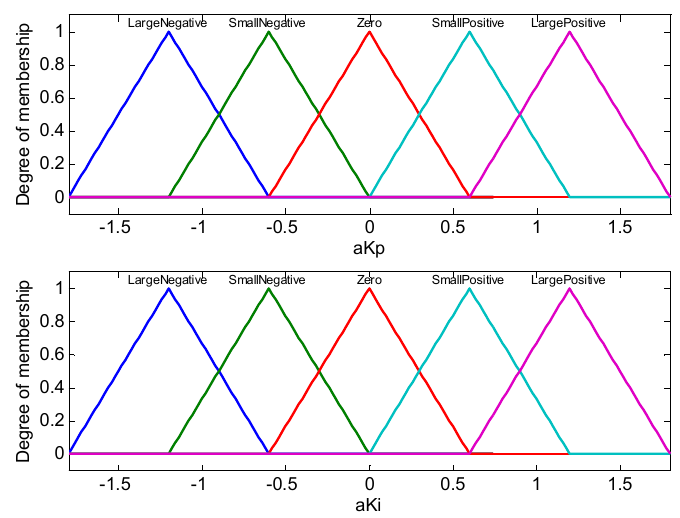
Figure 13. The membership functions of inputs and outputs.